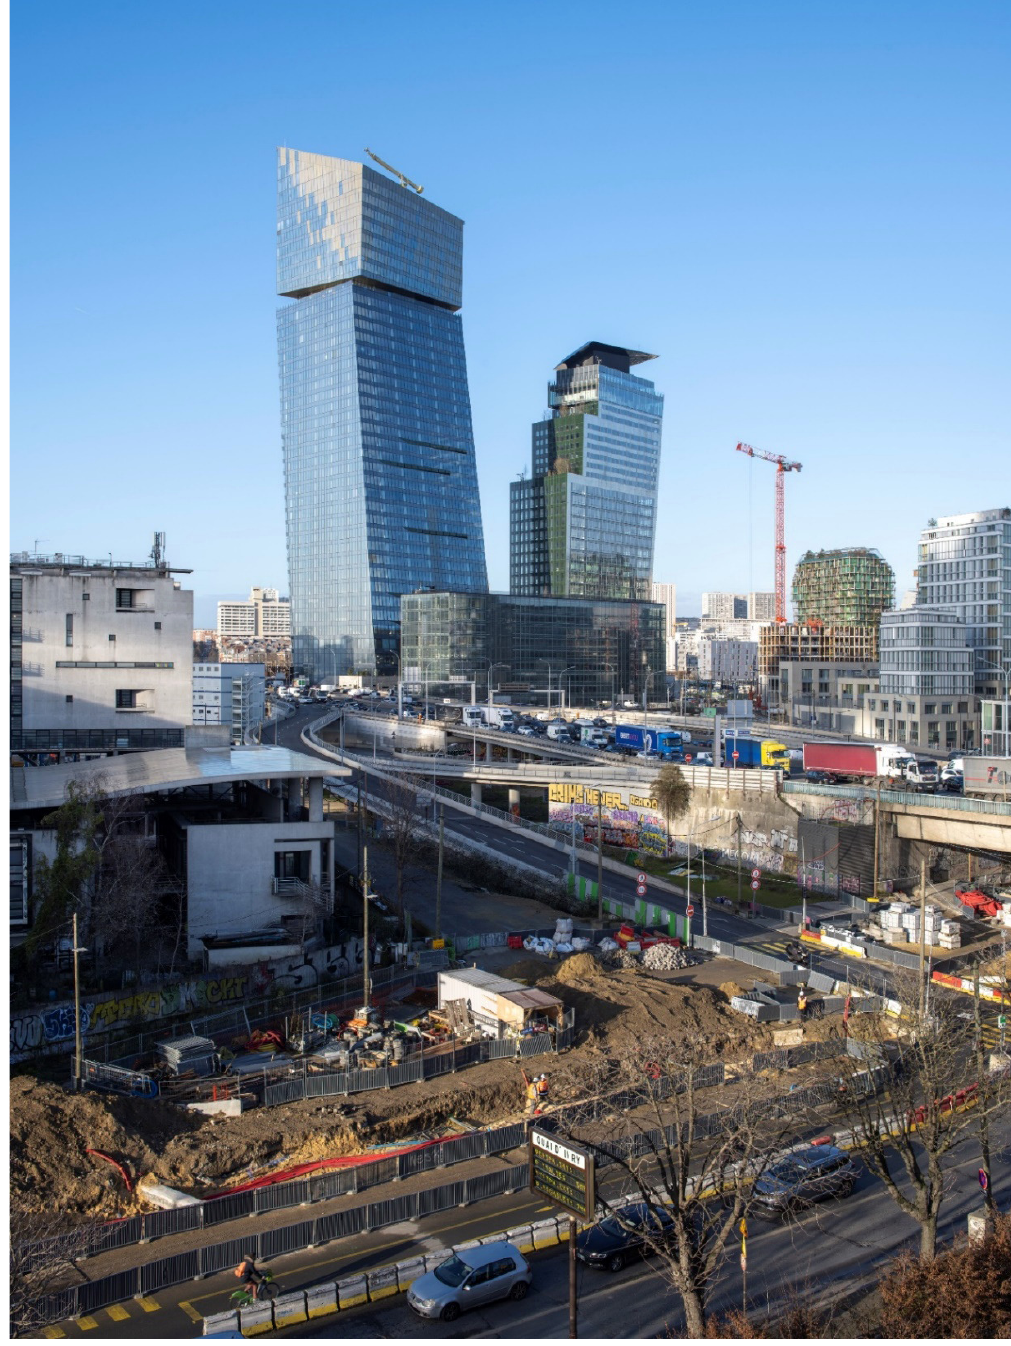
Figure 2. Tours Duo, Paris. Source: Photo by © Martin